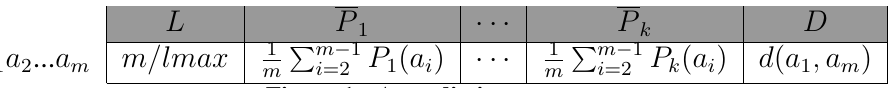
Figure 1: A prediction